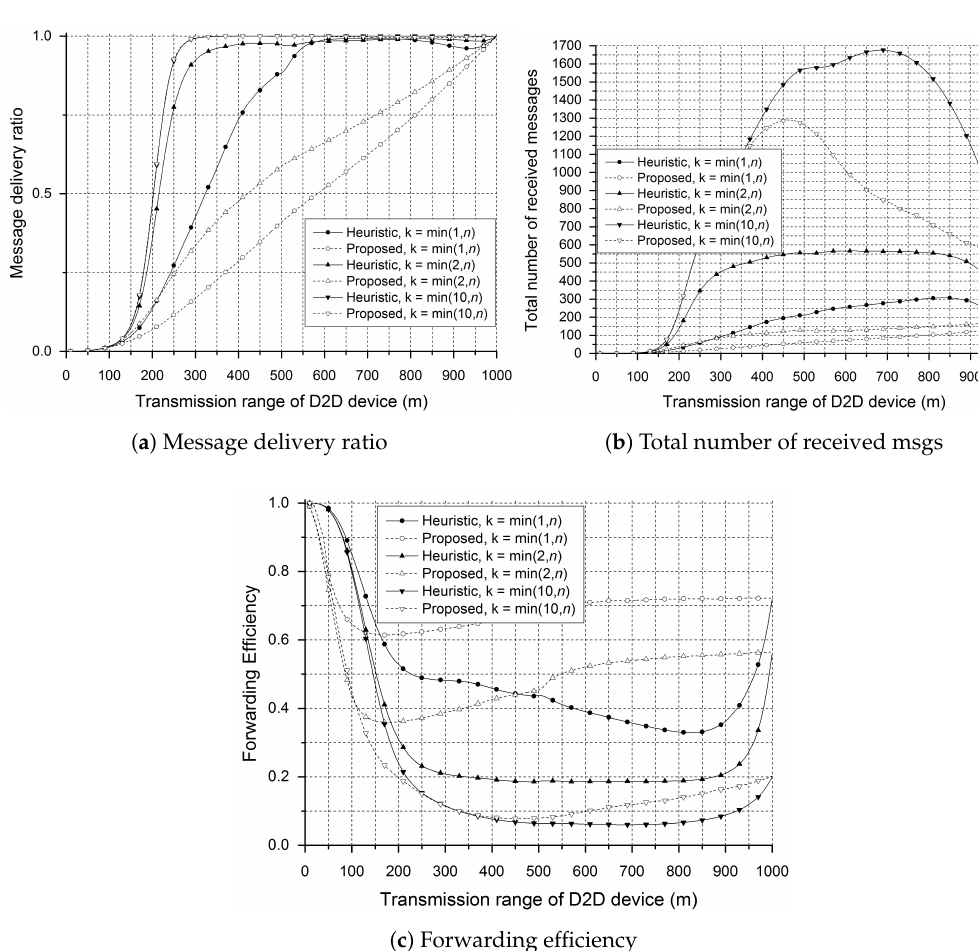
Figure 5. Message delivery ratio, total number of received messages and forwarding efficiency vs. ¯ R when N = 100.